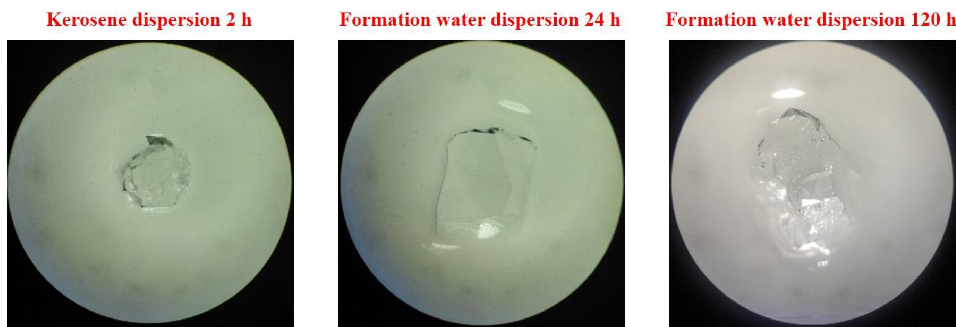
Figure 4. Micrograph of preformed particle gel after dispersion. 2. Gel